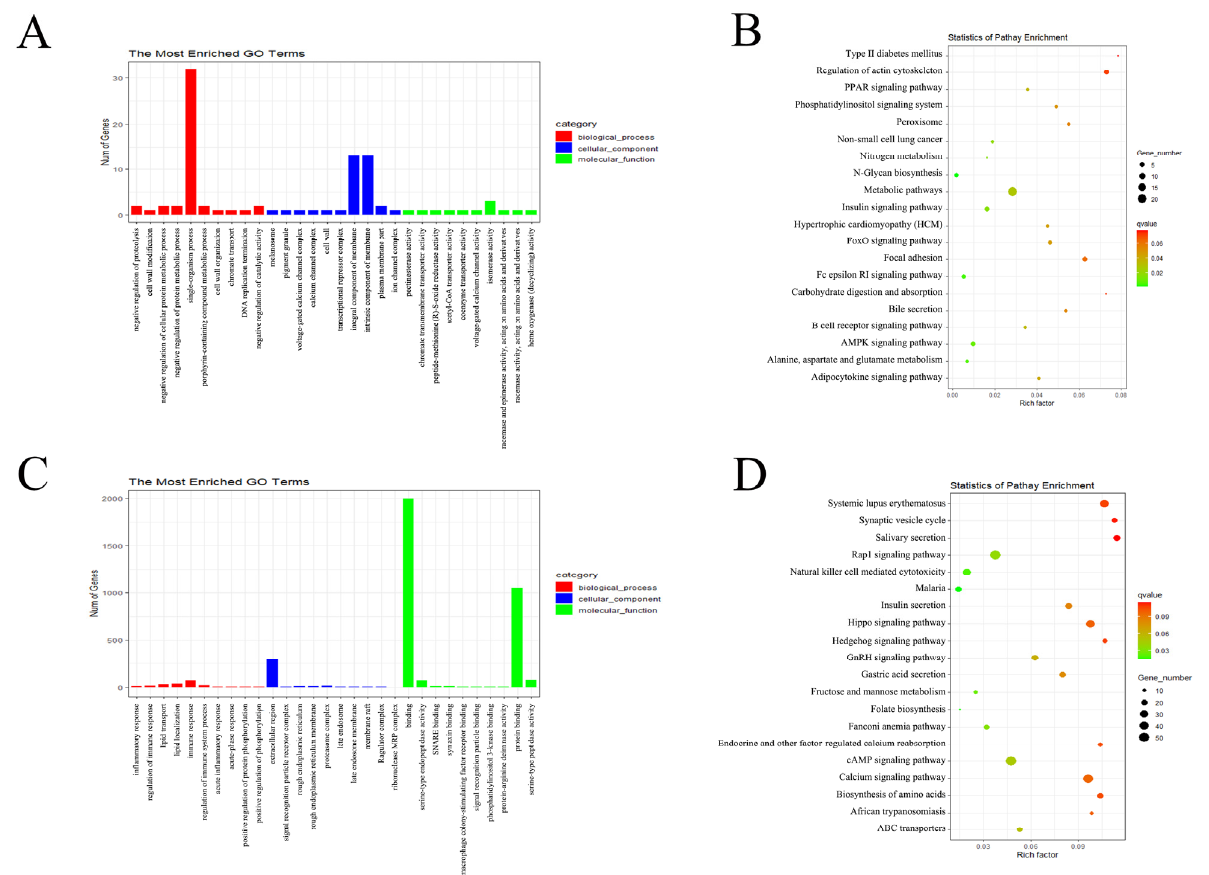
Figure 3. Top annotated GO terms ( A ) and top enriched KEGG pathways ( B ) of source genes of DE circRNAs. Top annotated GO terms ( C ) and top enriched KEGG pathways ( D ) of target genes of DE miRNAs.